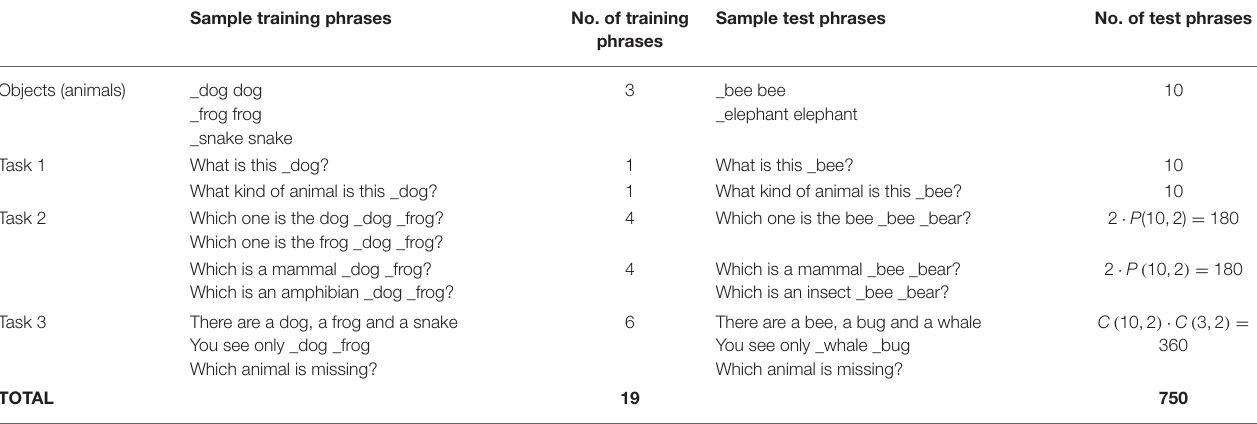
TABLE 1 | The number of phrases and the structure of the training/test sets, to validate the generalisation capabilities of the cognitive architecture at